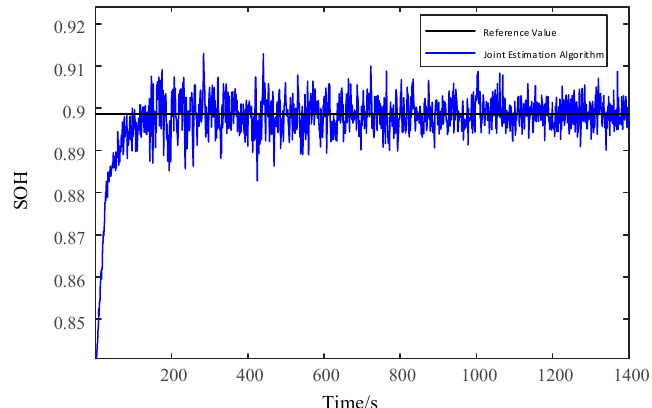
Figure 13. Ohmic resistance estimation curve of UDDS driving cycles based on the joint estimation algorithm.